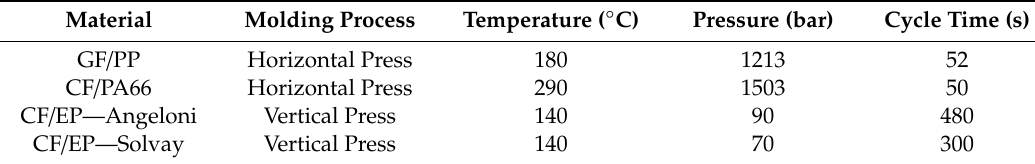
Table 1. Thermoforming parameters for the chosen materials.